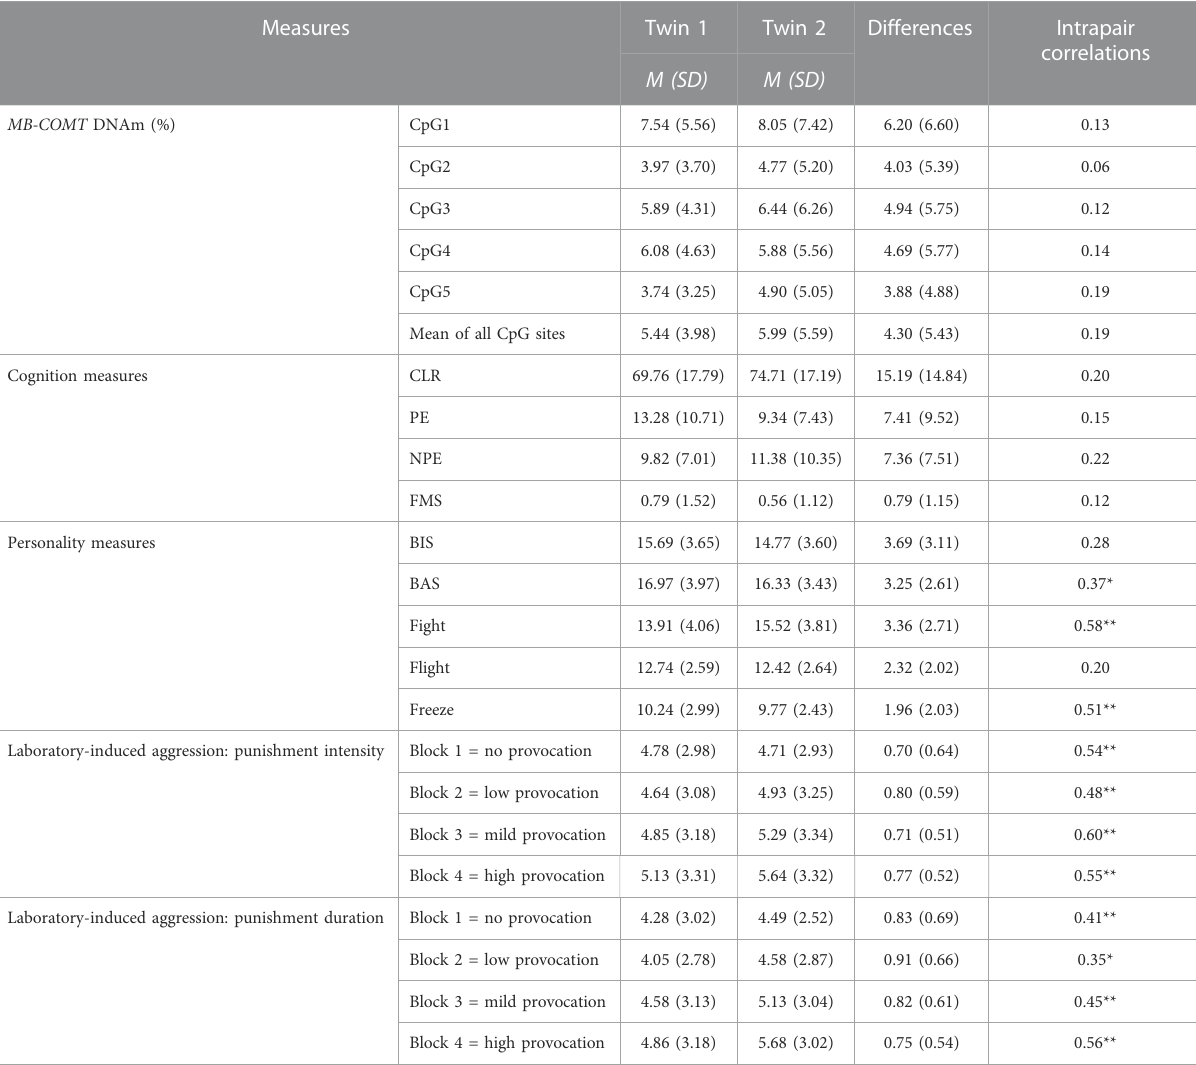
TABLE 3 Descriptive statistics and twin correlation coef fi cients for MB-COMT DNAm and all phenotypic